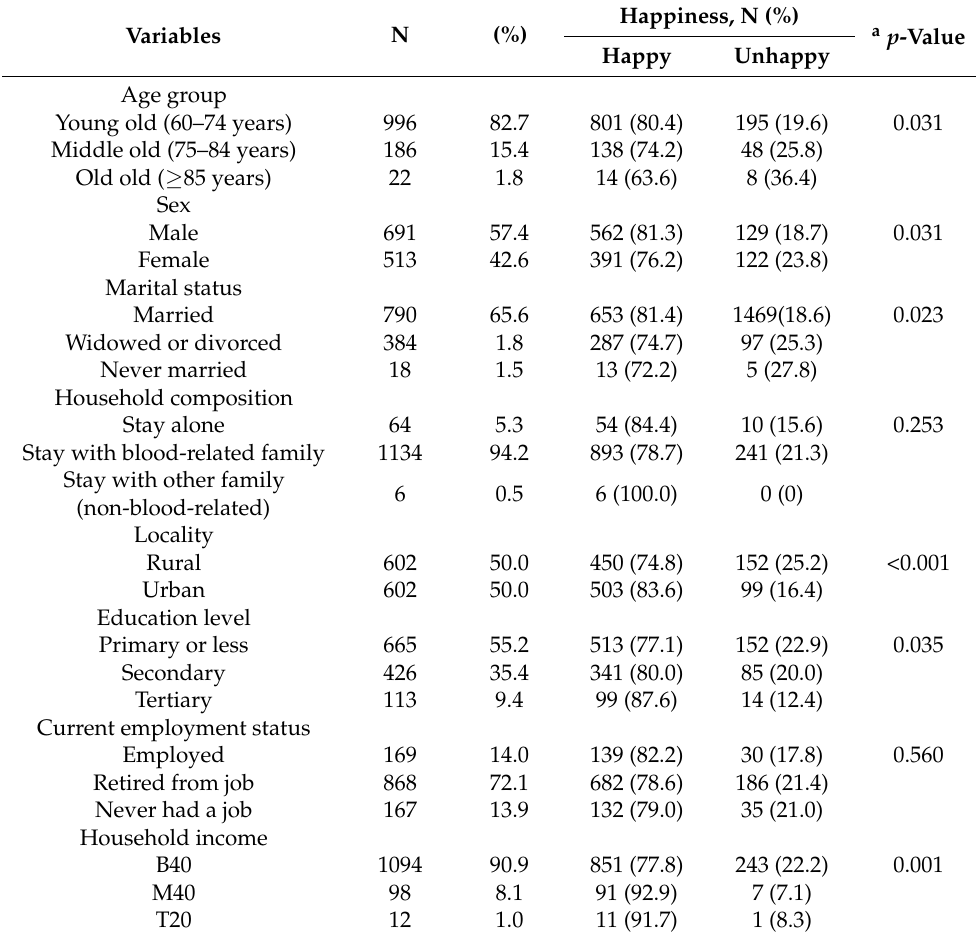
Table 1. Descriptive and bivariate analysis of factors associated with